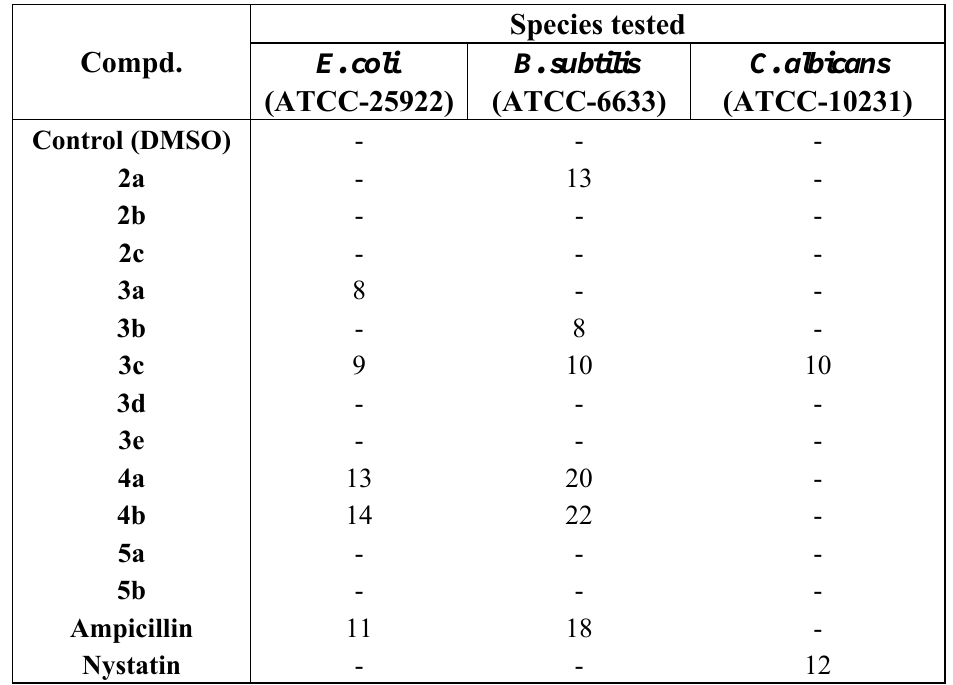
Table 1. Antimicrobial activity of the synthesized compounds expressed as size of the inhibition zone (mm/mg